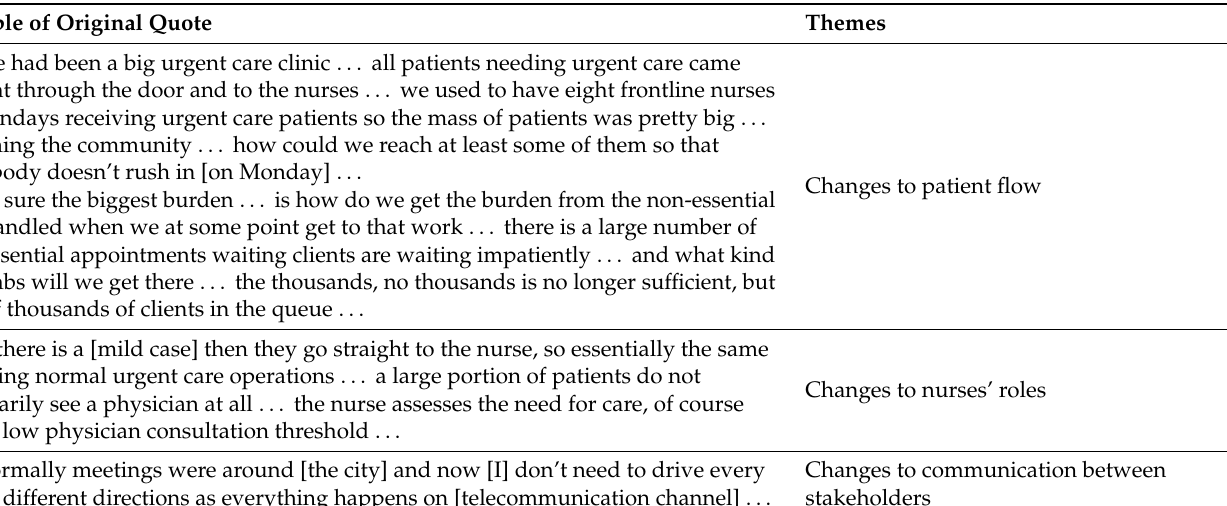
Table 2. Examples of original quotes depicting state of